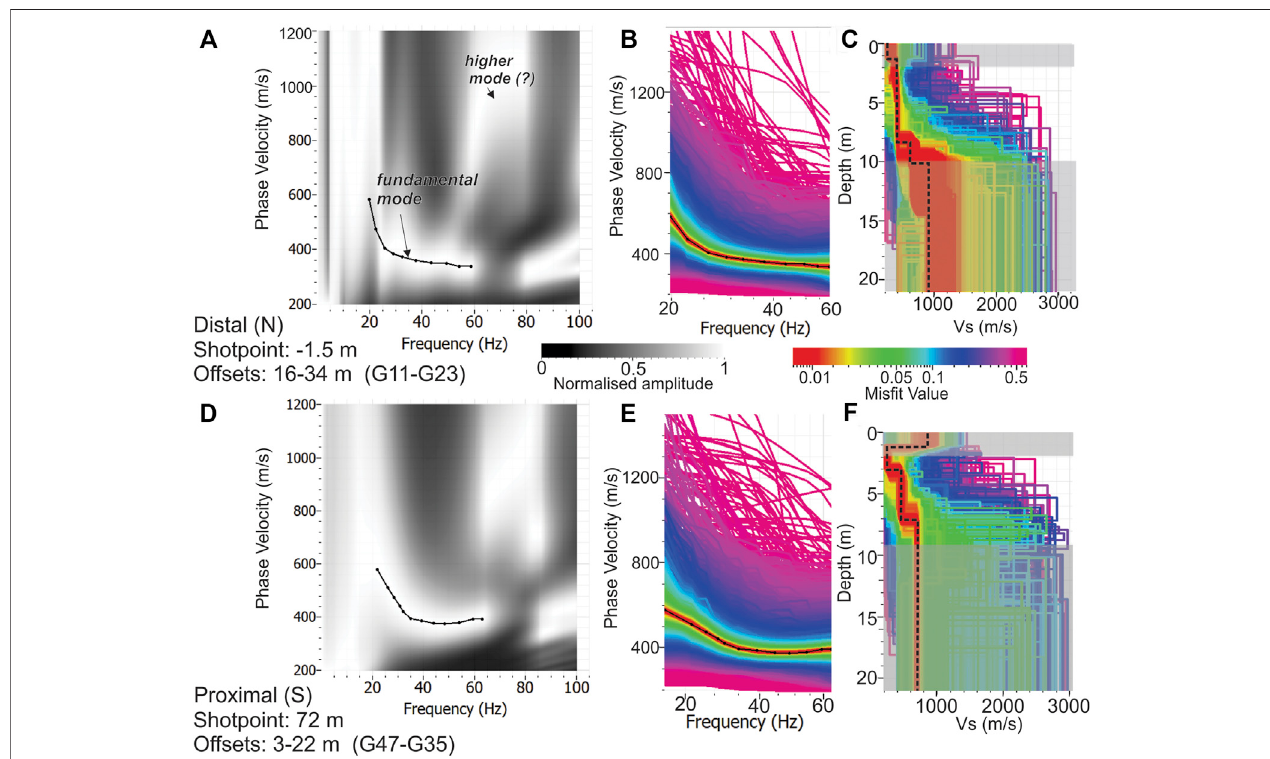
FIGURE 10 | MASW dispersion curves and inversion results from the Hummocky Site: (A – C) use geophones G 16 to G 23 and the ice proximal shotpoint, at − 1.5 m and (D – F) use geophones G 47 to G 35 and the ice distal shotpoint, at 72 m. Picked dispersion curves for each site are shown in A & D. All modelled dispersion curvestested intheinversion areshown inB&E,withcorrespondingmis fi tsplottedasthecolourscale, highmis fi tmodels progressivelyoverlainbylowermis fi tmodels, and picked values displayed in black. C & F show all v s pro fi les associated with the modelled dispersion curves and corresponding mis fi ts, with minimum mis fi t v s pro fi le (black dashed line). The grey regions in C & F show approximate resolution limits de fi ned by Z min and Z max ( Table 1 ).